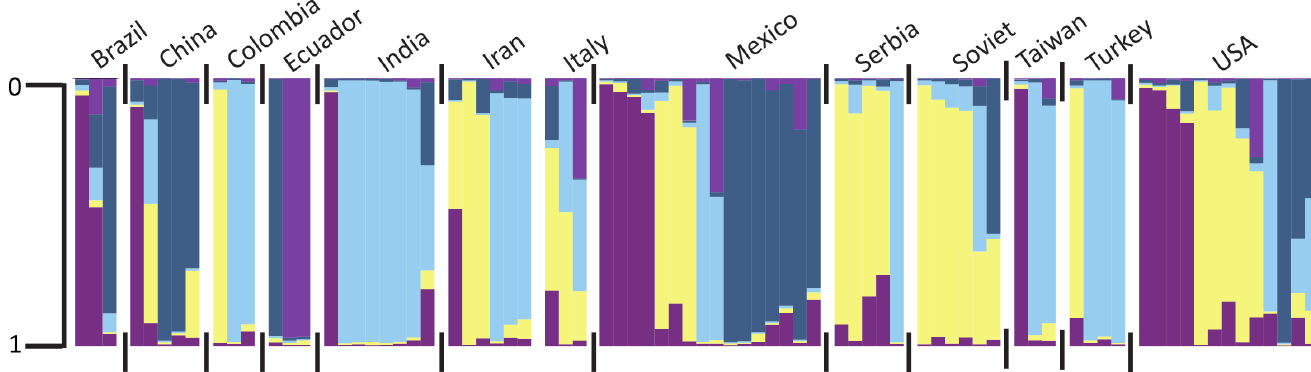
Fig 5. Population structure of pepper ( Capsicum annuum ) grouped by country of origin. Only countries represented by more than four individuals are included. Individuals are represented by their proportionate membership (0 to 1) in cluster 1 (purple), cluster 2 (light yellow), cluster 3 (sky blue), cluster 4 (steel blue), or cluster 5 (orchid). A white space and black tick marks separate subgroups of individuals.